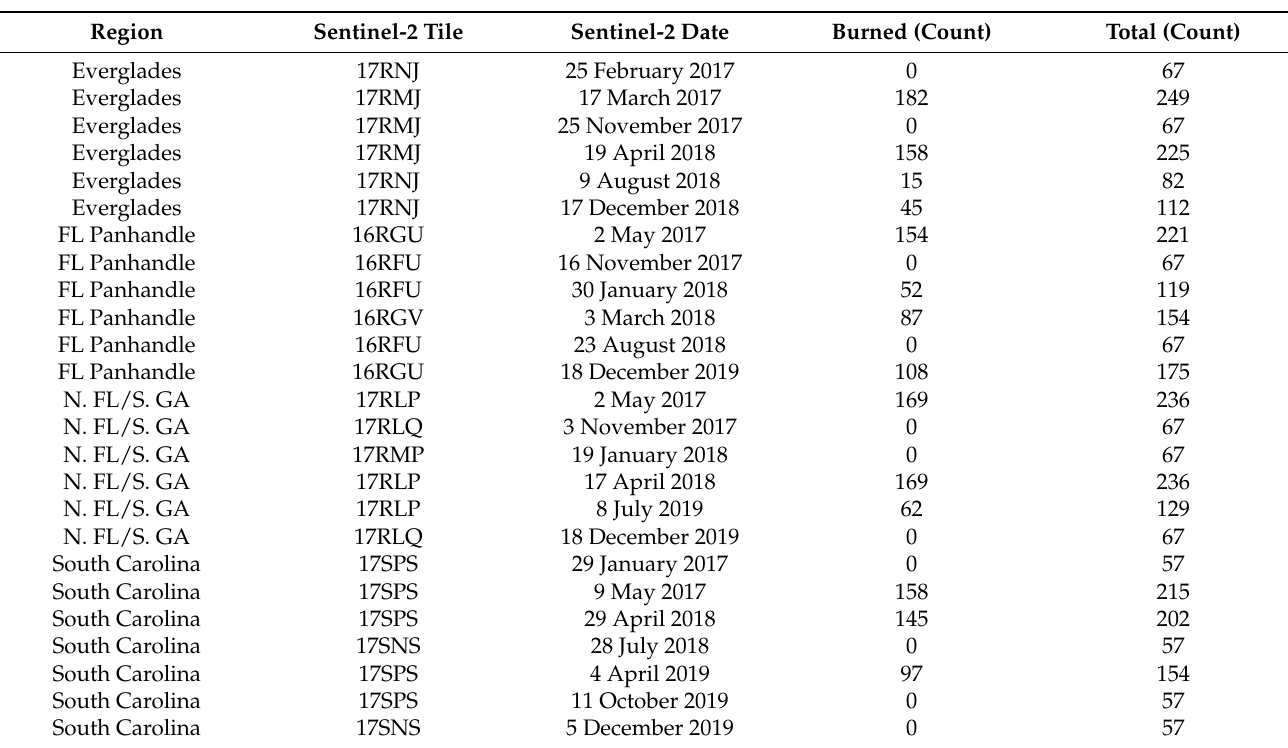
Table A1. Sentinel-2 images selected for training and the number of burned points randomly selected across each image. In each image 67 points were selected to represent unburned, except for the South Carolina training images, where 57 unburned points were selected per image to account for the inclusion of an extra training image. FL = Florida, GA = Georgia, N. = north, S. =